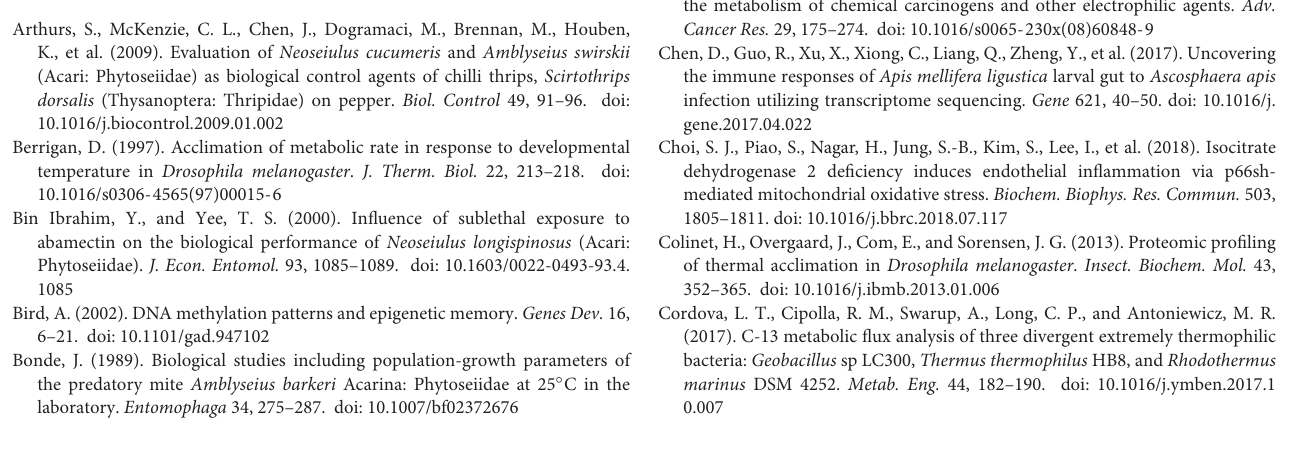
FIGURE S1 | Summary of iTRAQ metrics from Neoseiulus barkeri proteomes. TABLE S1 | Distribution of annotated species.